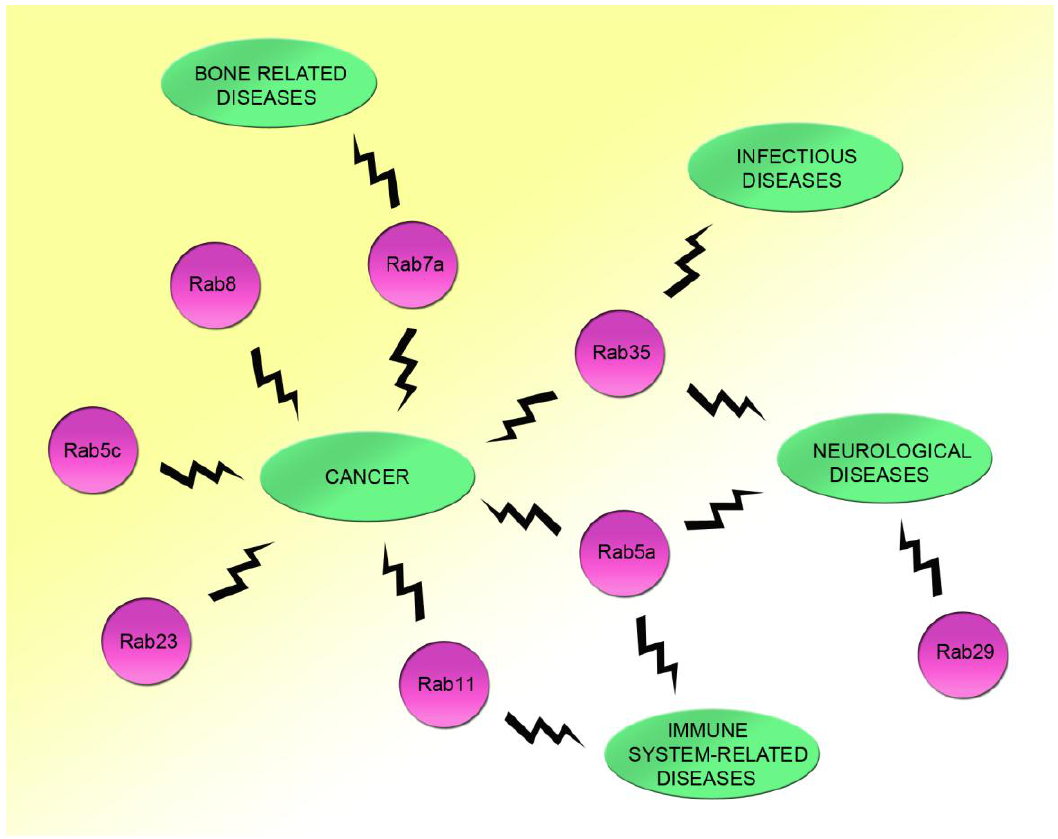
Figure 2. Demonstrated relationships between Rac1 and Rab proteins, whose alterations are responsible for human diseases. The interactions of Rab5c, Rab23, and Rab8 with Rac1 are important for cell migration and cancer. The coordination between Rab11 and Rac1 has a key role in immune system regulation and cancer. Rab5a and Rac1 interaction could be relevant for immune system diseases, neurological pathologies, and tumors. Rab29 and Rac1 contribute together to the onset of neurological diseases, whereas Rac1 and Rab35 interaction is altered in infectious diseases, neurological pathologies, and cancer. Finally, Rab7a has a key role in cell migration and adhesion together with Rac1, and alterations of the Rac1-Rab7a interaction could be important for bone-related diseases.